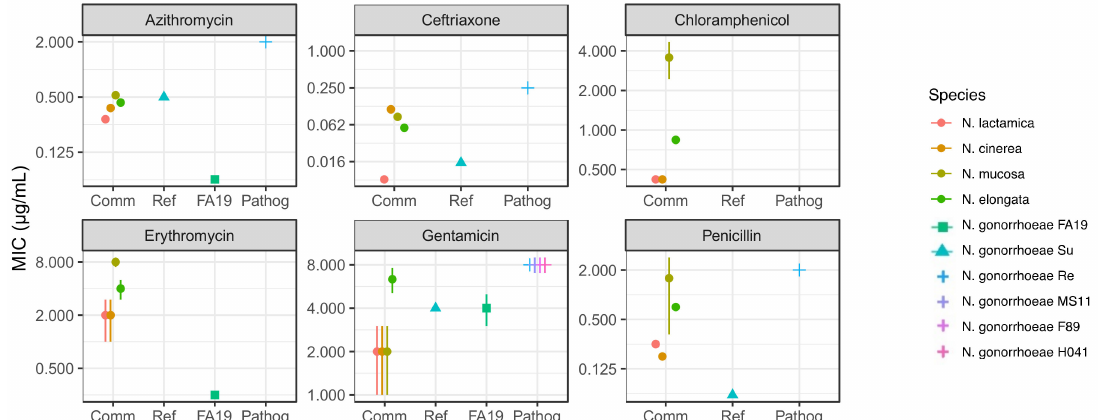
Figure 3. Minimal Inhibitory Concentrations ( µ g/mL) of several antibiotics in commensal (Comm, circles) Neisseria species compared to N. gonorrhoeae susceptible (Su, Ref), FA19 (Ref, square) and resistant (Re, Pathog, cross) strains. MIC were performed 3 times independently, using 2-fold serial dilutions of the antibiotics. When necessary, ranges (as color-coded bars) of MIC are displayed for specific data points that are plotted as a midpoint of the range.